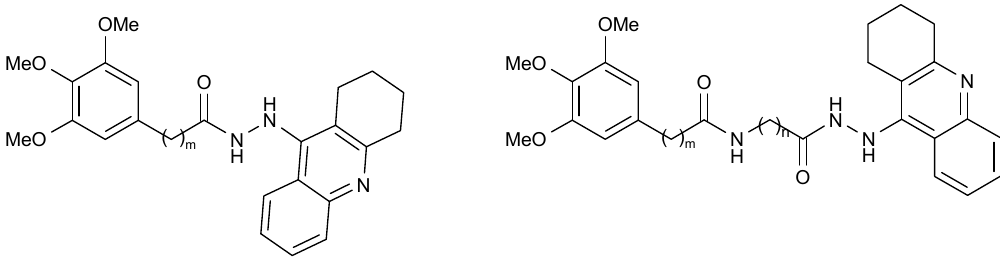
Figure 17. Trimethoxybenzene-tacrine hybrids 81 and 82